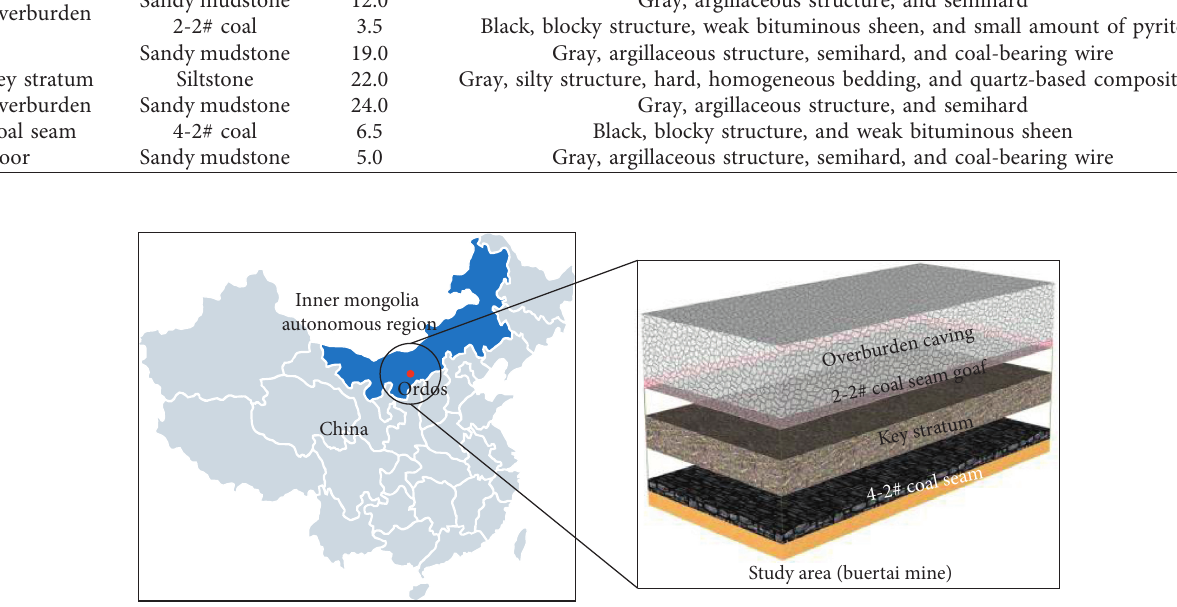
Figure 1: Mine location and working face layout.